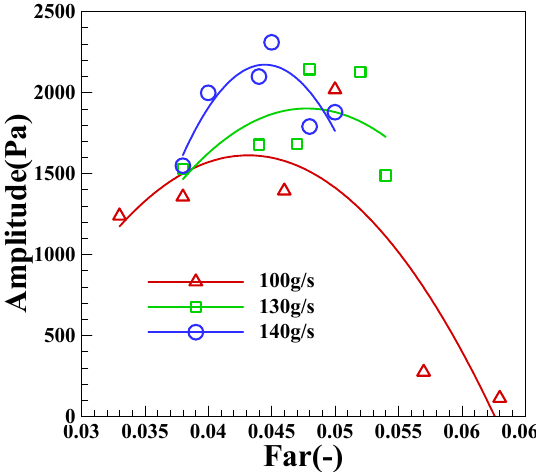
Figure 16. Variation of the DP peak value under different inlet air mass flow.